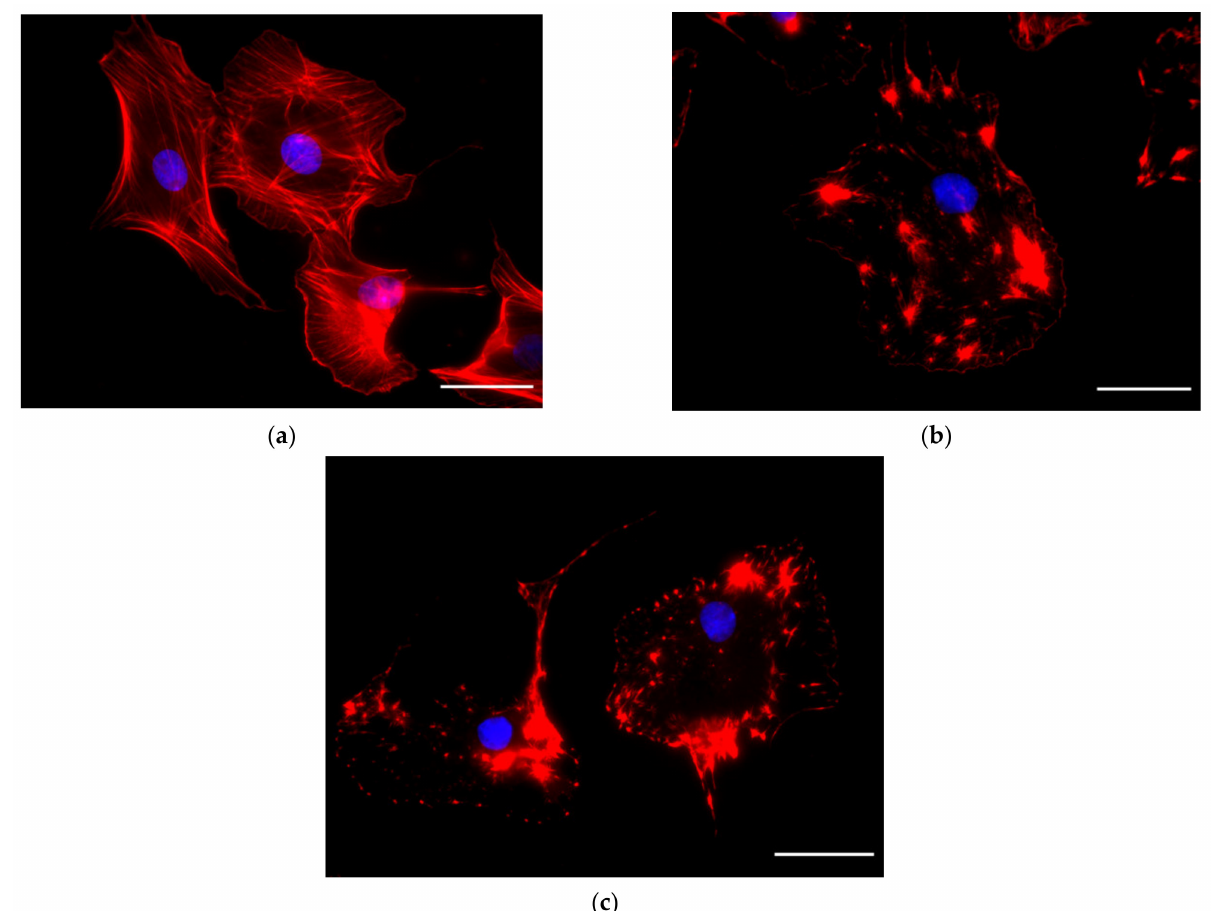
Figure 5. Effect of Cyt-D 5 µ M on cytoskeletal actin. Fluorescent images for control ( a ) and cells after 10 min ( b ) and 30 min ( c ) of treatment. Scale bar: 40 µ